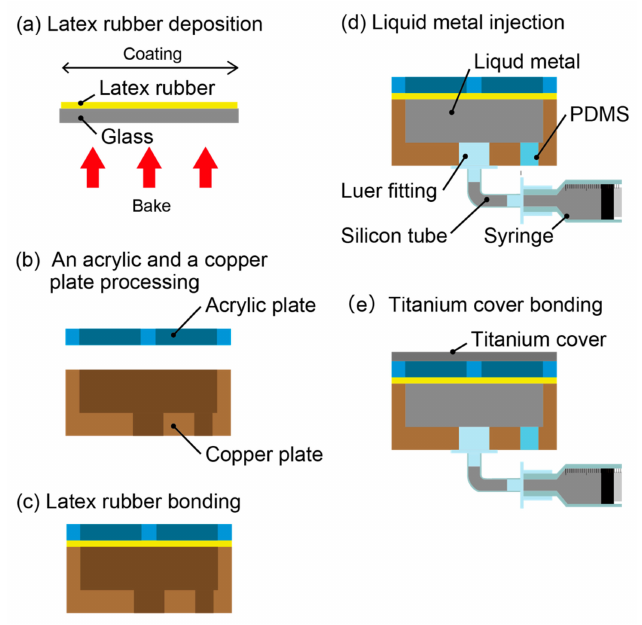
Figure 4. Fabrication process of the thermal sensation tactile